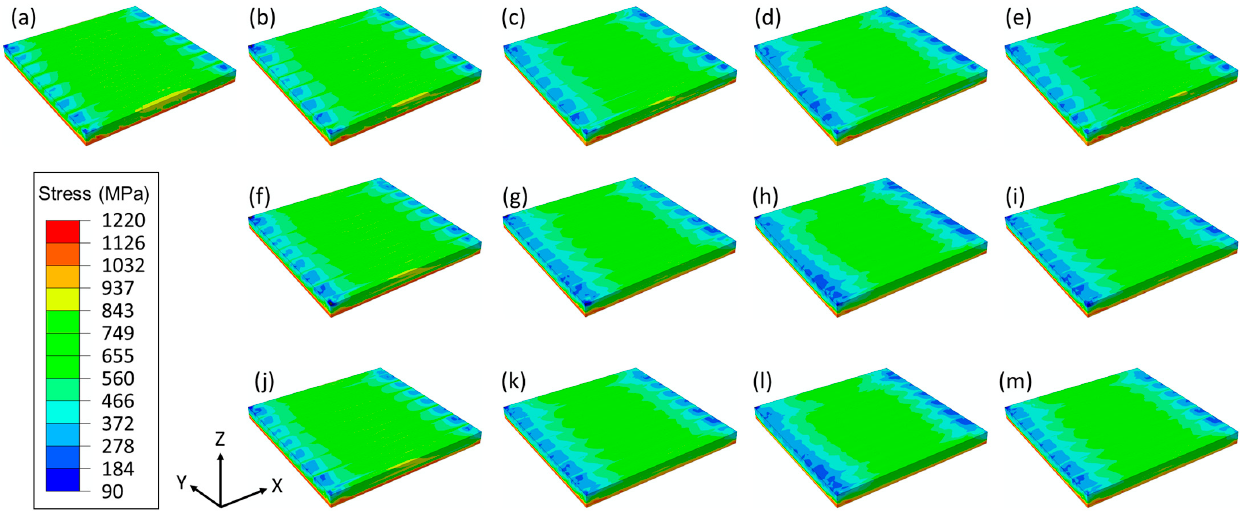
Figure 9. Residual von Mises stress contours for different scanning modes and process parameters: